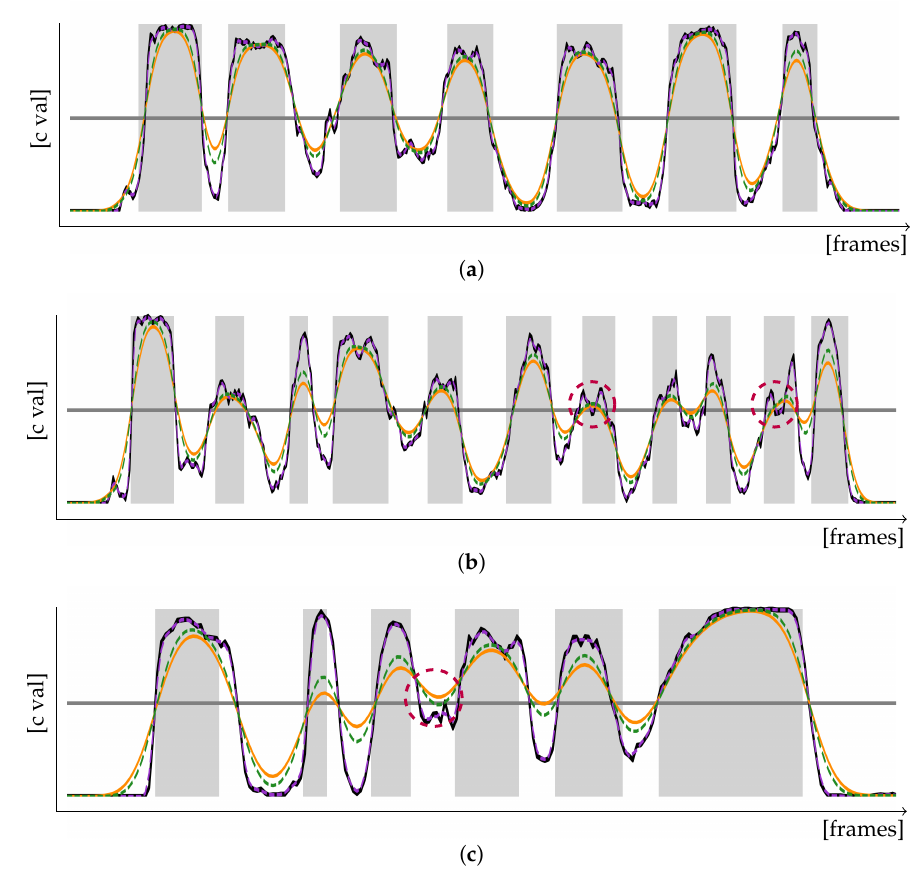
Figure 2. Confidence curves c (black, solid) and their respective smoothed versions c A (orange, solid), c B (green, striped) and c C (purple, striped) of sentence-based label predictions in relation to the binary decision threshold of 0.5 (gray, solid) and the actual segment boundaries of the signed expression. ( a ) The confidence curves follow a sine-like pattern closely related to the ground truth segmentation. ( b ) c A and c B are more robust to inter-word misclassifications caused by minimal peaks of c falling below the threshold (red circles, dashed). ( c ) Strong smoothing of c A can smooth out peaks and result in information loss (red circle,